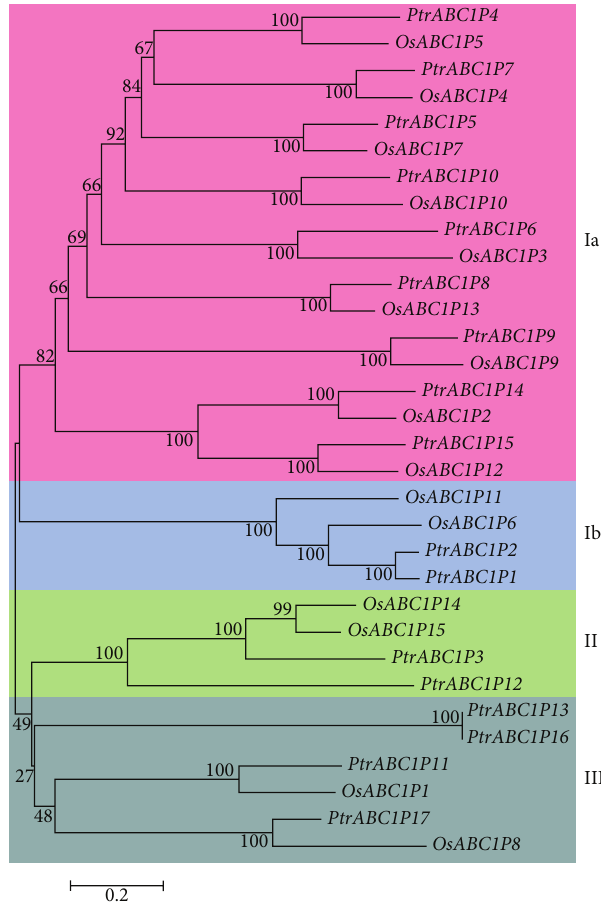
Figure 2: Phylogenetic tree of the ABC1 protein families in P. trichocarpa and rice. The tree was generated using the MEGA5 program with the neighbor-joining method. Pink represents group Ia, blue represents group Ib, green represents group II, and gray represents group III. OsABC1P represents ABC1 proteins in rice, while PtrABC1P represents ABC1 proteins in P. trichocarpa.